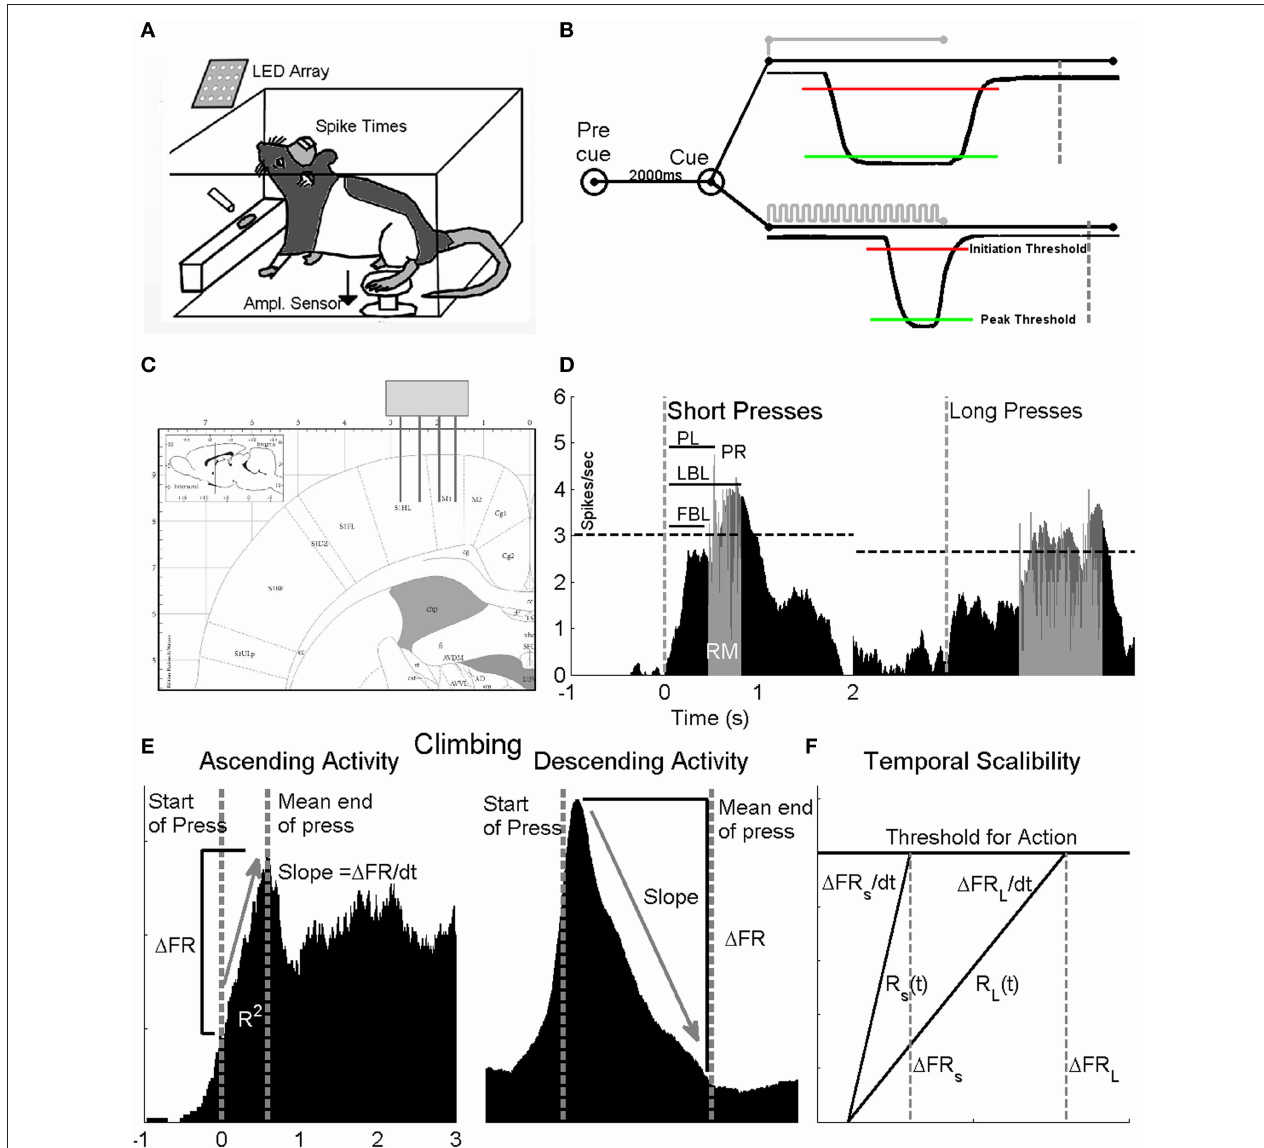
FIGURE 1 | Experimental design. Two groups of animals were trained to press a pedal with their hindlimb in response to GO cues for a water reward. (A) Neural activity from the HLSMC was recorded from animals performing the task in a closed behavioral chamber and stored for off-line analysis. (B) The first animal group (non-interval trained) was trained with a single GO cue and the duration of the press was not relevant for reward (no image shown). The second group (interval trained) was trained to give a long duration press ( > 1.5) in response to a solid light cue (top trace) and a short press ( < 1) in response to a flashing light cue (bottom trace). Both groups of animals were required to sit quietly for a 2s pre cue period, otherwise, a false positive was generated and the trial ended. For presses to be valid, the amplitude sensor was required to cross an initiation threshold (red line) and remain below a peak threshold (red line) for the cued duration before returning to baseline. If successful, animals were rewarded at fixed period point (IT: short: 750ms, long: 500ms after end of press; nIT 500ms after end of press) following completion of correct press duration (dashed lines). Both groups of animals made short and long presses. (C) Stereotaxic location of 4 × 4 microelectrode array implants in rat HLSMC (from Paxinos and Watson,